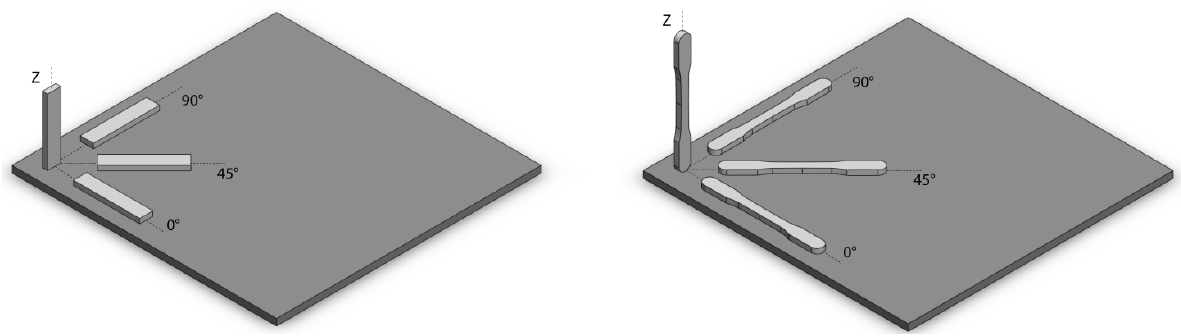
Figure 2. The four different orientations considered for producing DMLS aluminum alloy